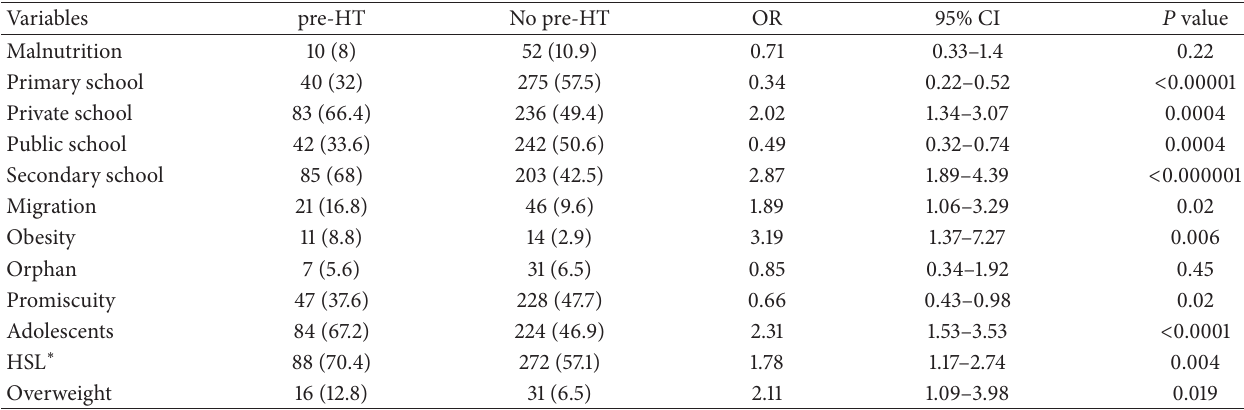
Table 3: Univariable odds of pre-HT.